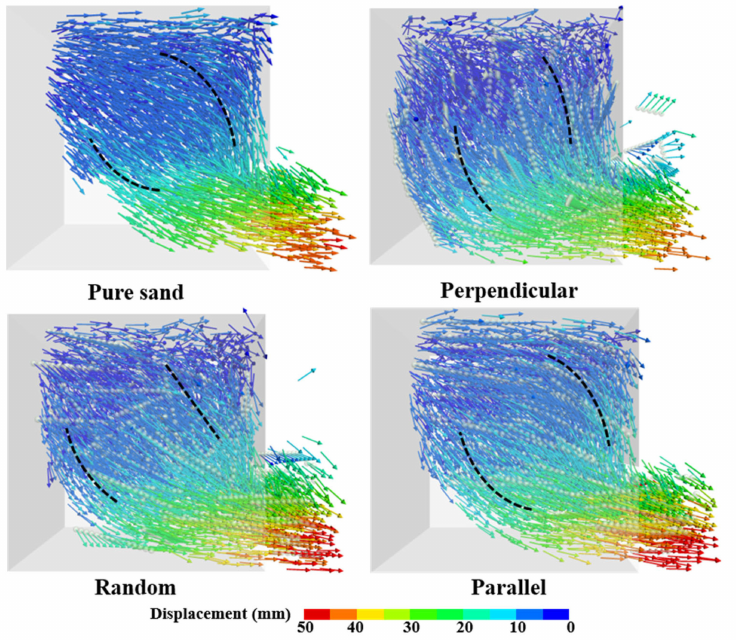
Figure 12. The displacement field for reinforced sand with different orientation